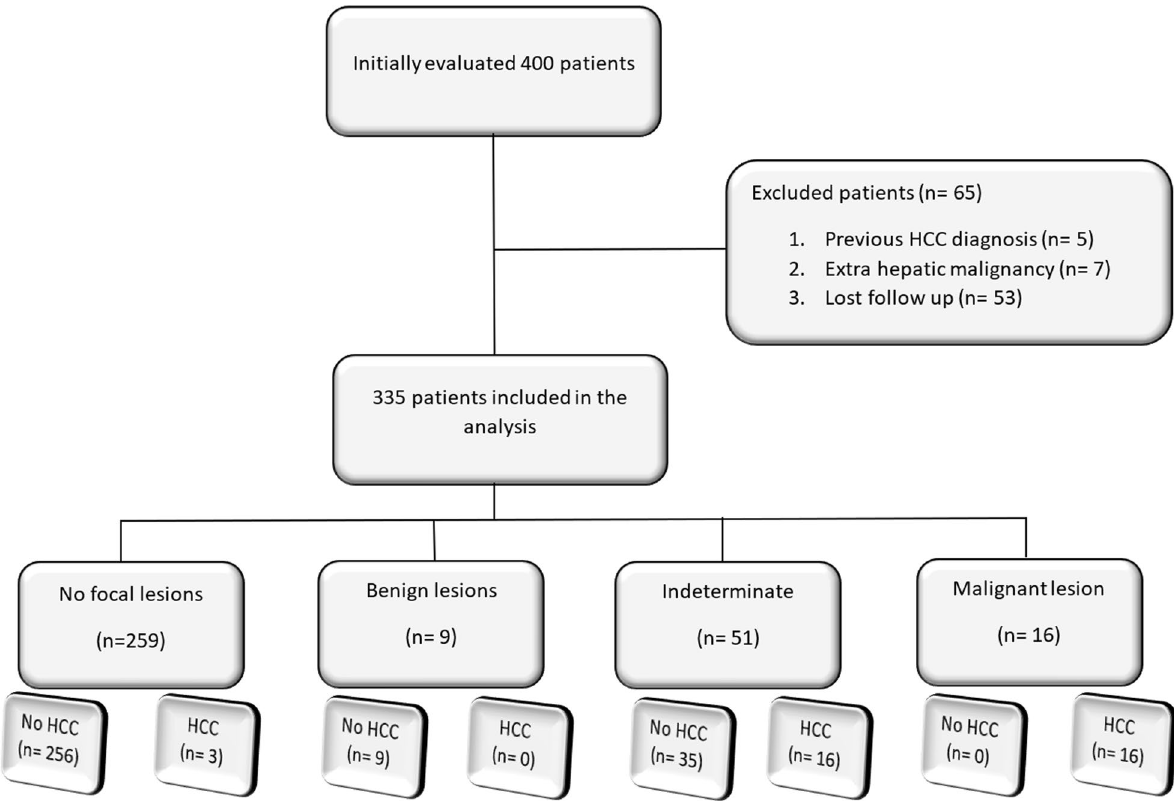
Fig. 1 Flowchart of the study population